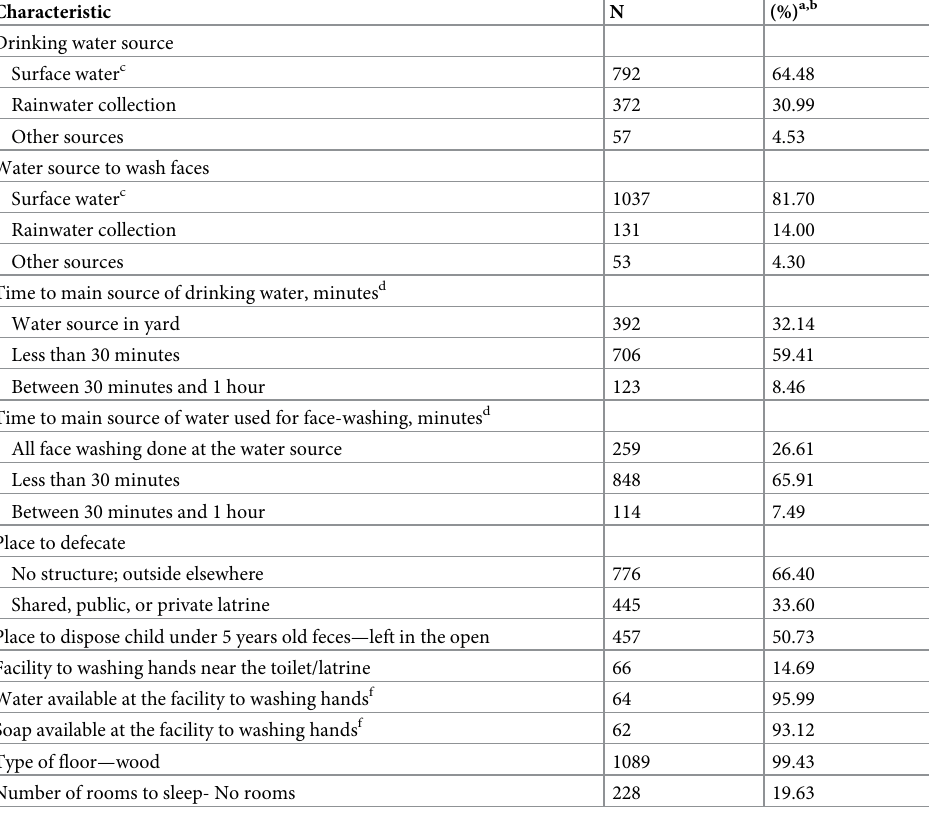
Table 7. Household-level factors for trachoma and soil-transmitted helminthiases of children aged 1–9 years in rural communities of Loreto Department, Peru,